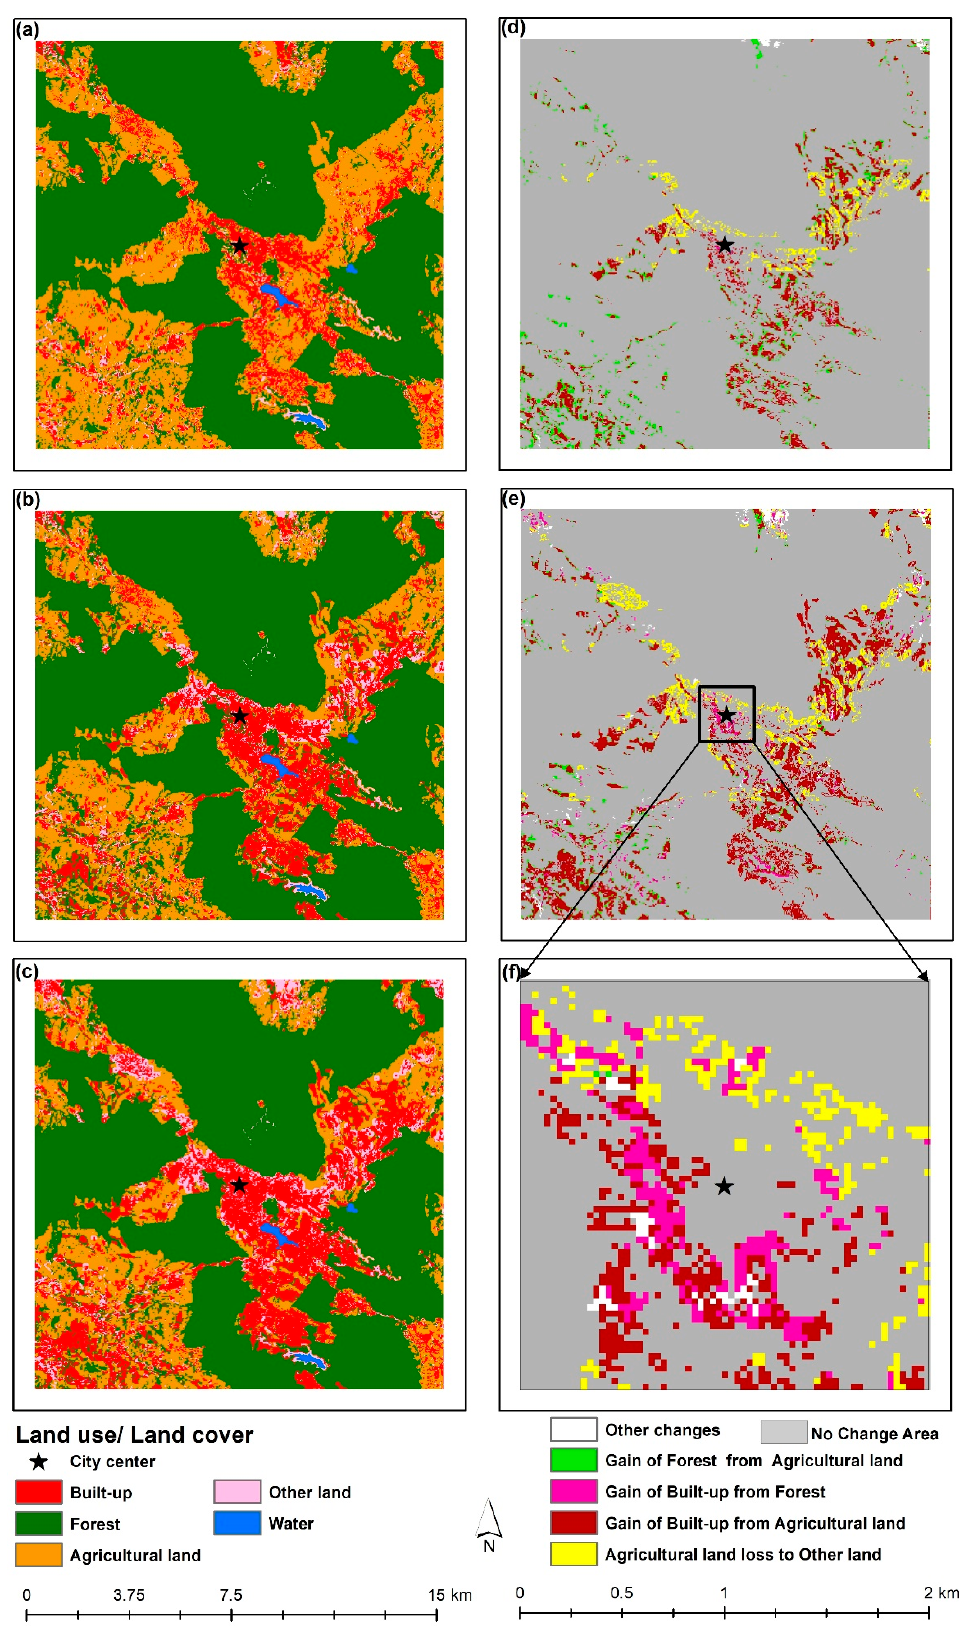
Figure 5. Land use and land cover changes in the Nuwara Eliya area: ( a ) Land use / cover in 2017; ( b ) Land use / cover in 2027; ( c ) Land use / cover in 2037; ( d ) Land use / cover change from 2017 to 2027; ( e ) Land use / cover change from 2017 to 2037; and ( f ) Zoom view of land use / cover change from 2017 to 2037 map.